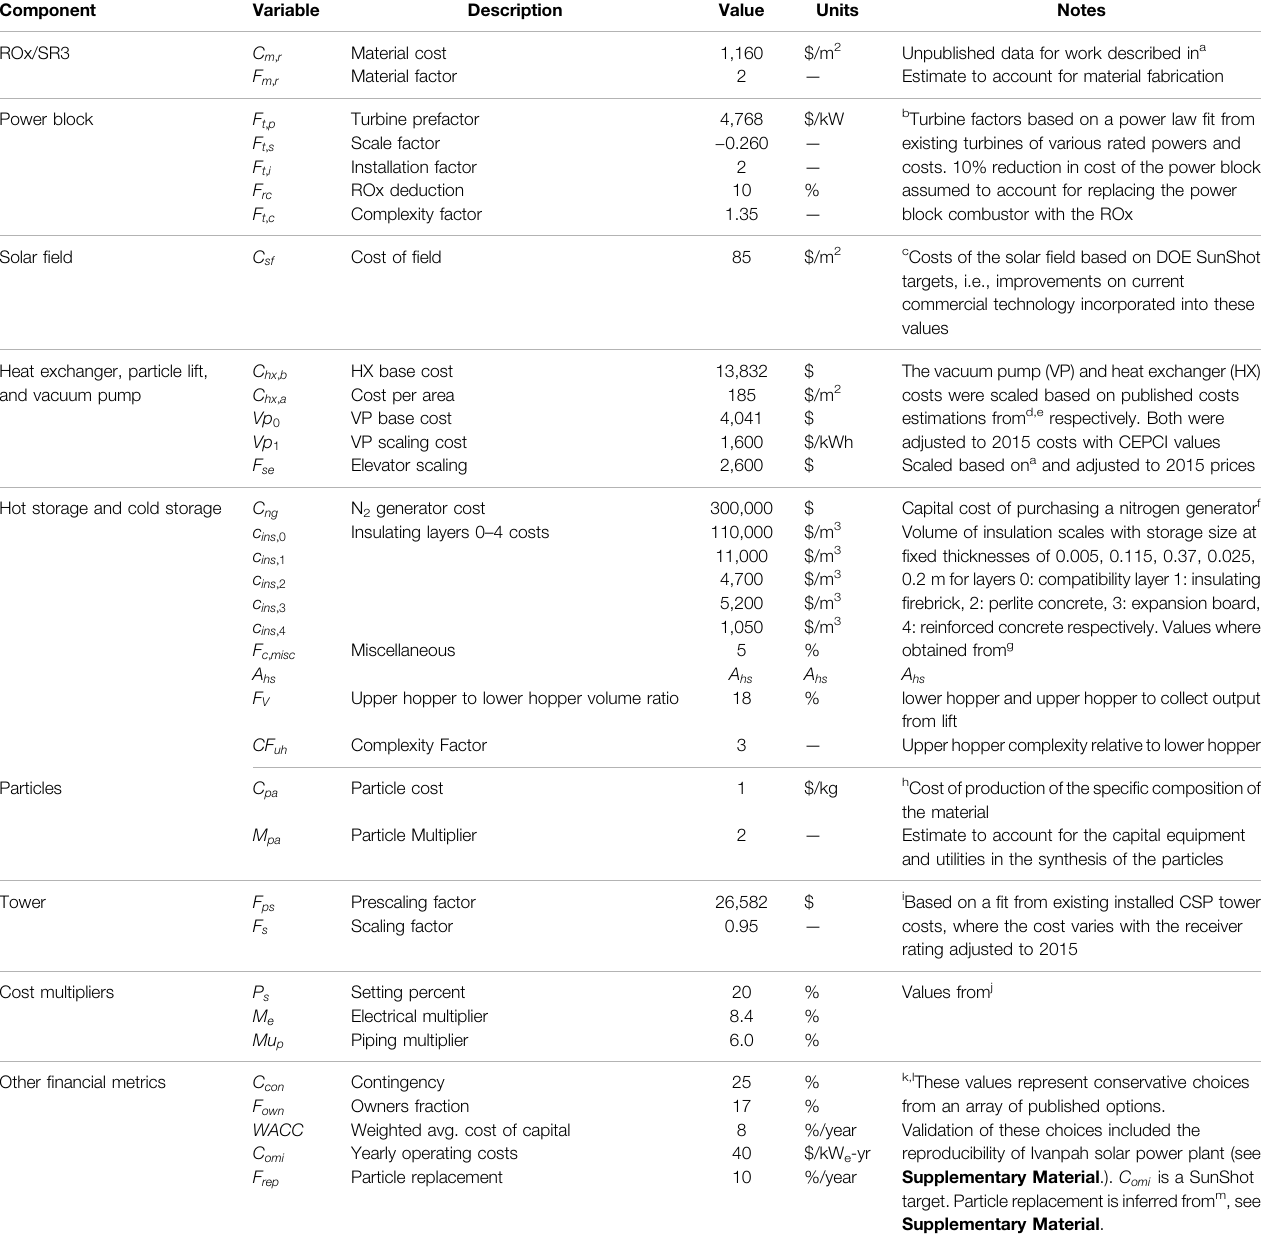
TABLE 4 | Parameter values for economic